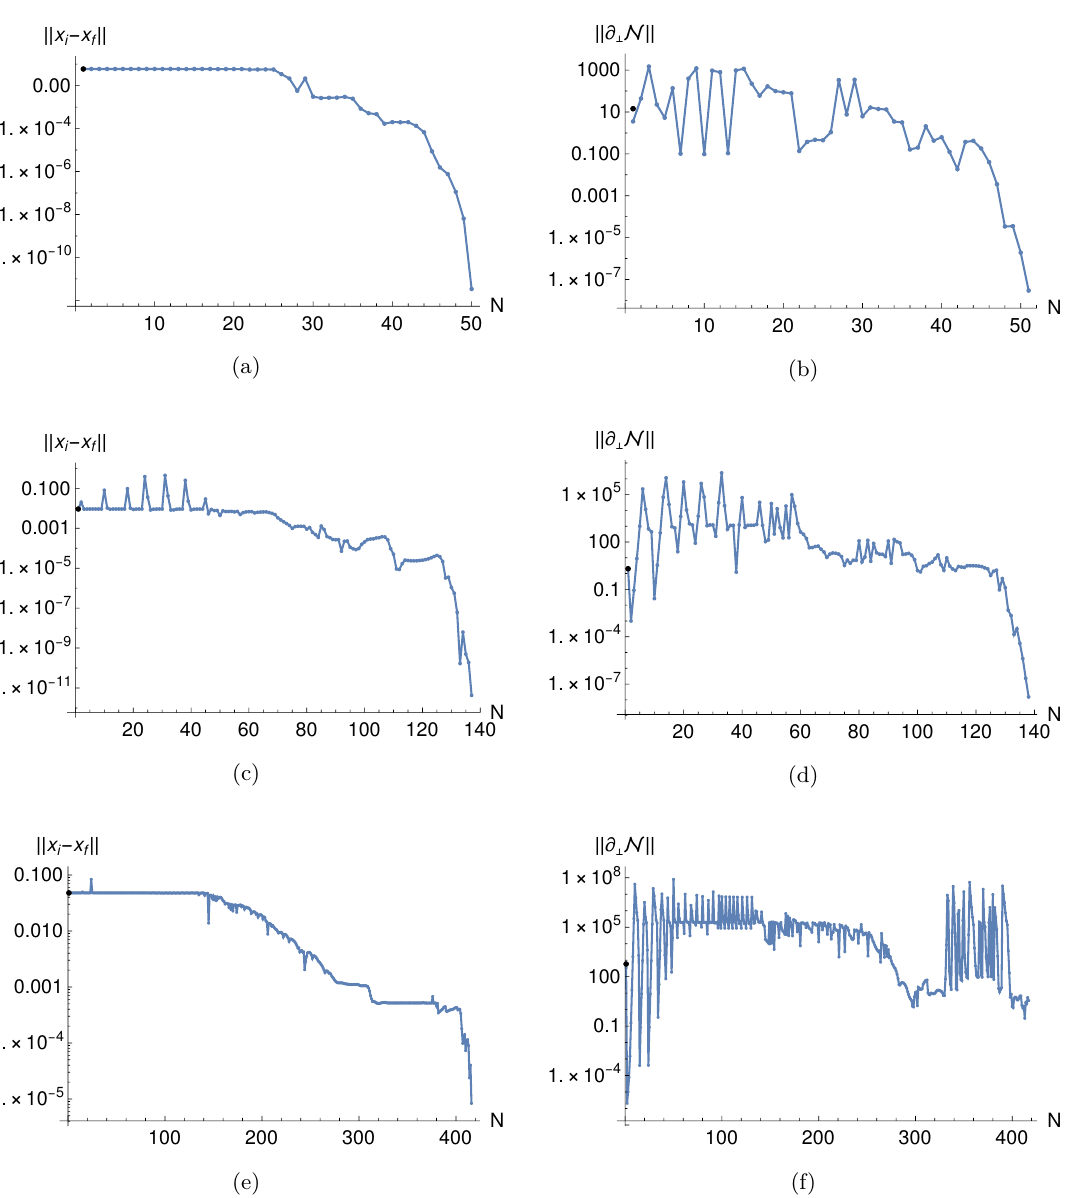
Figure 7 . (a), (c), (e): logarithmic plot of the distance k x i − x f k between the point x i and the eventually found extremal point x for a typical parameter extremization run in respectively a 4 , f 7 and 13 dimensional parameter space. Red dots represent BFGS steps while blue dots indicate function calls within the line searches. (b), (d), (f): logarithmic plot of the norm of the gradient components orthogonal to the direction that is being extremized for the same runs. (The large jumps around point 330 to 390 in the last plot are due to the fact that we reset the approximated Hessian and changed the finite step size used to compute the gradient in the hope of improving